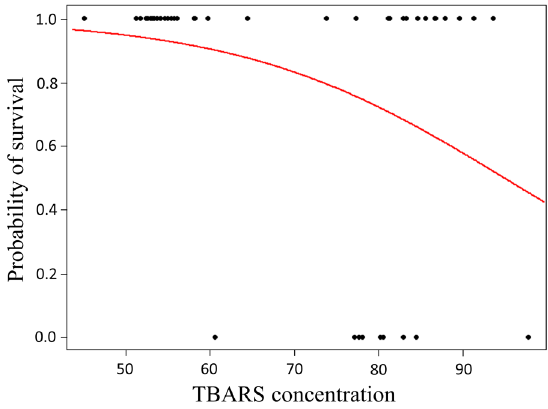
Figure 4. Survival probability over a sixteen days period of nestlings (alive = 1 and dead = 0) in relation to the TBARS expressed as nmol MDA equivalent/ml.